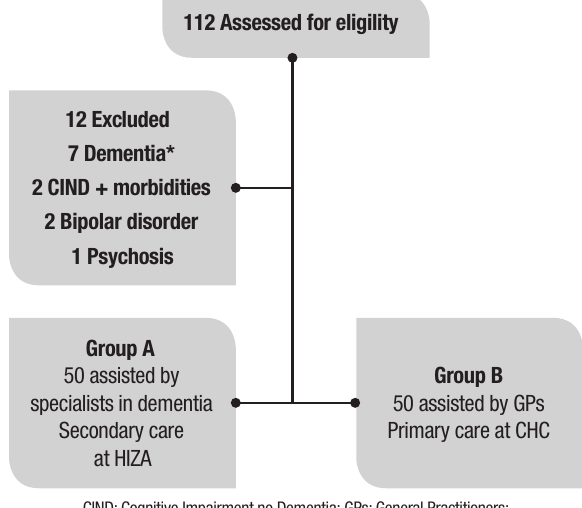
Figure 1. Flow diagram shows initial recruitment, exclusions and